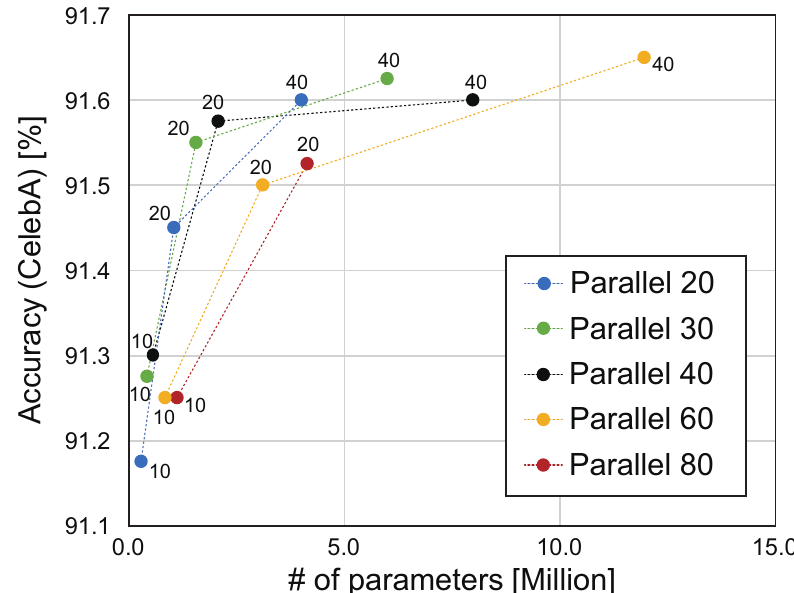
Figure 8. Comparison of the parameter efficiency of MM-CNN using Mean and CPR with the different number of parallels for CelebA. The numbers near each point in the graph indicate the hyperparameter c .